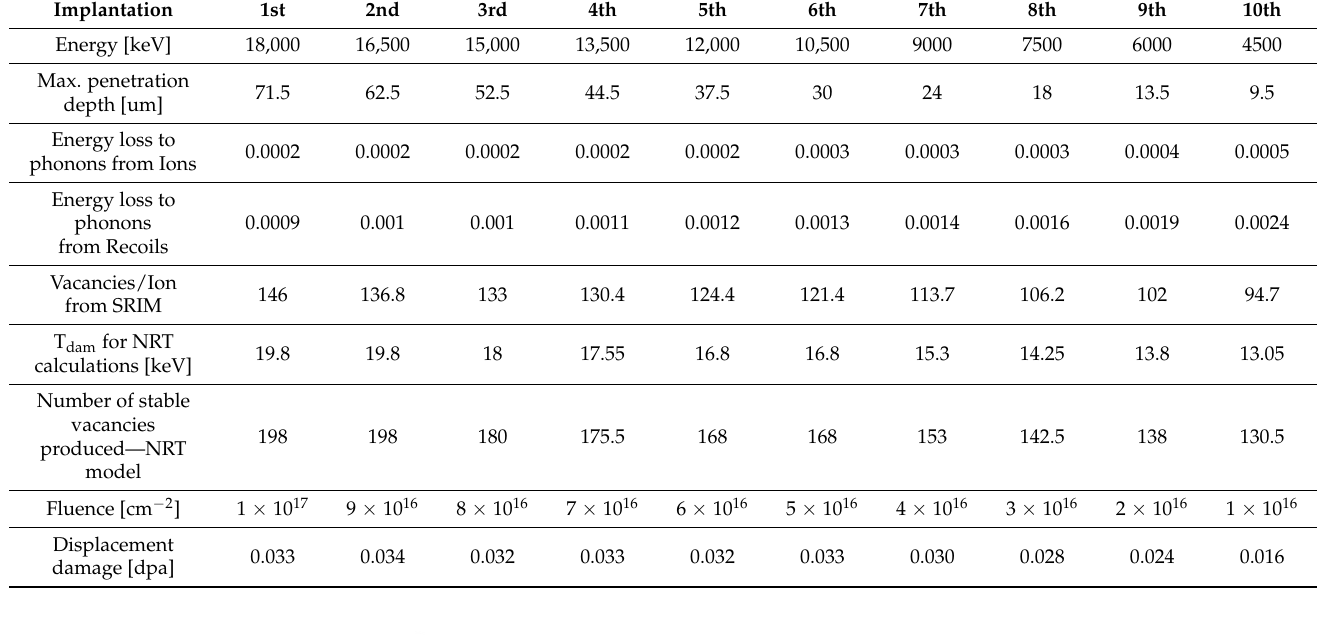
Table 1. Proposed multi-energy He-implantation characteristics.